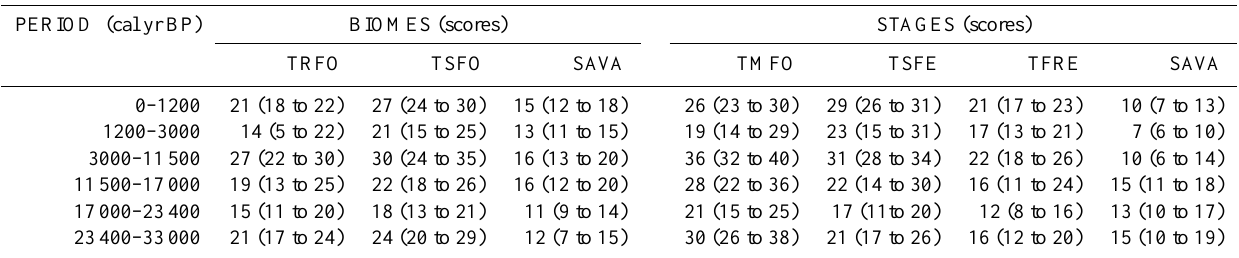
Table 5. Mean and minima and maxima (between brackets) values of scores of reconstructed potential biomes and successional stages in the Barombi Mbo pollen